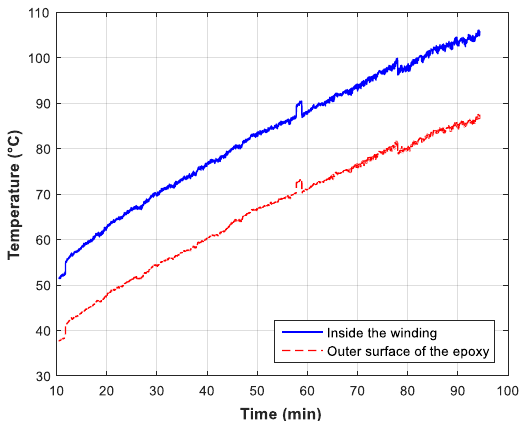
Figure 18. Temperature measured by the PT100 sensors installed inside the winding and in the outer surface of the epoxy.